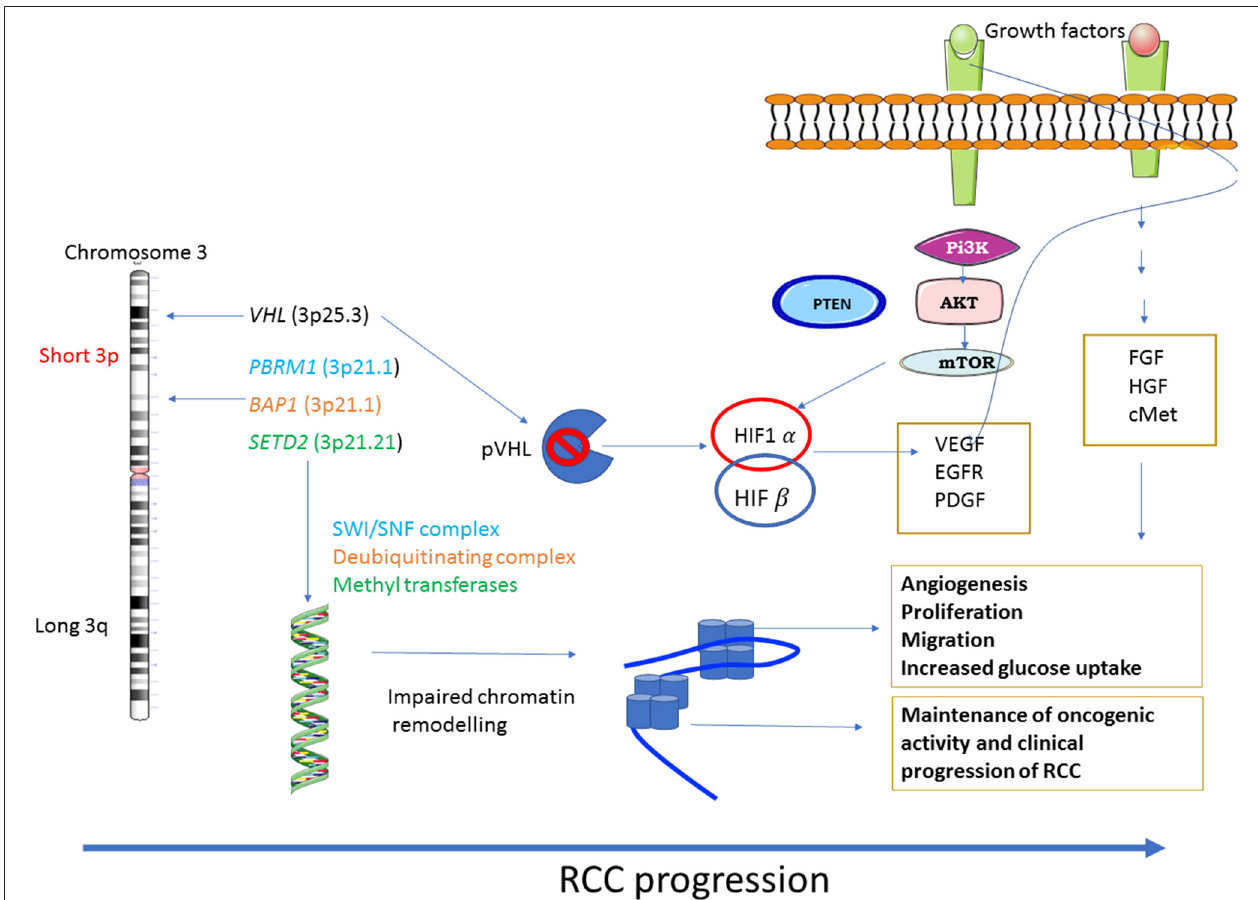
FIGURE 1 | Major dysregulated pathways in RCC: RCC shows a diverse range of genetic mutations. Loss of chromosome 3p tumor suppressor genes play a major role in the pathogenesis of RCC. Genes mostly affected are VHL , the gene responsible for sensing oxygen levels within a cell, chromatin remodeling genes such as PBRM1 , BAP1 and SETD2 . The other signaling pathways that are associated with RCC progression are PI3K-AKT-mTOR and the pathways regulated by FGF, HGF and its receptor c-MET.